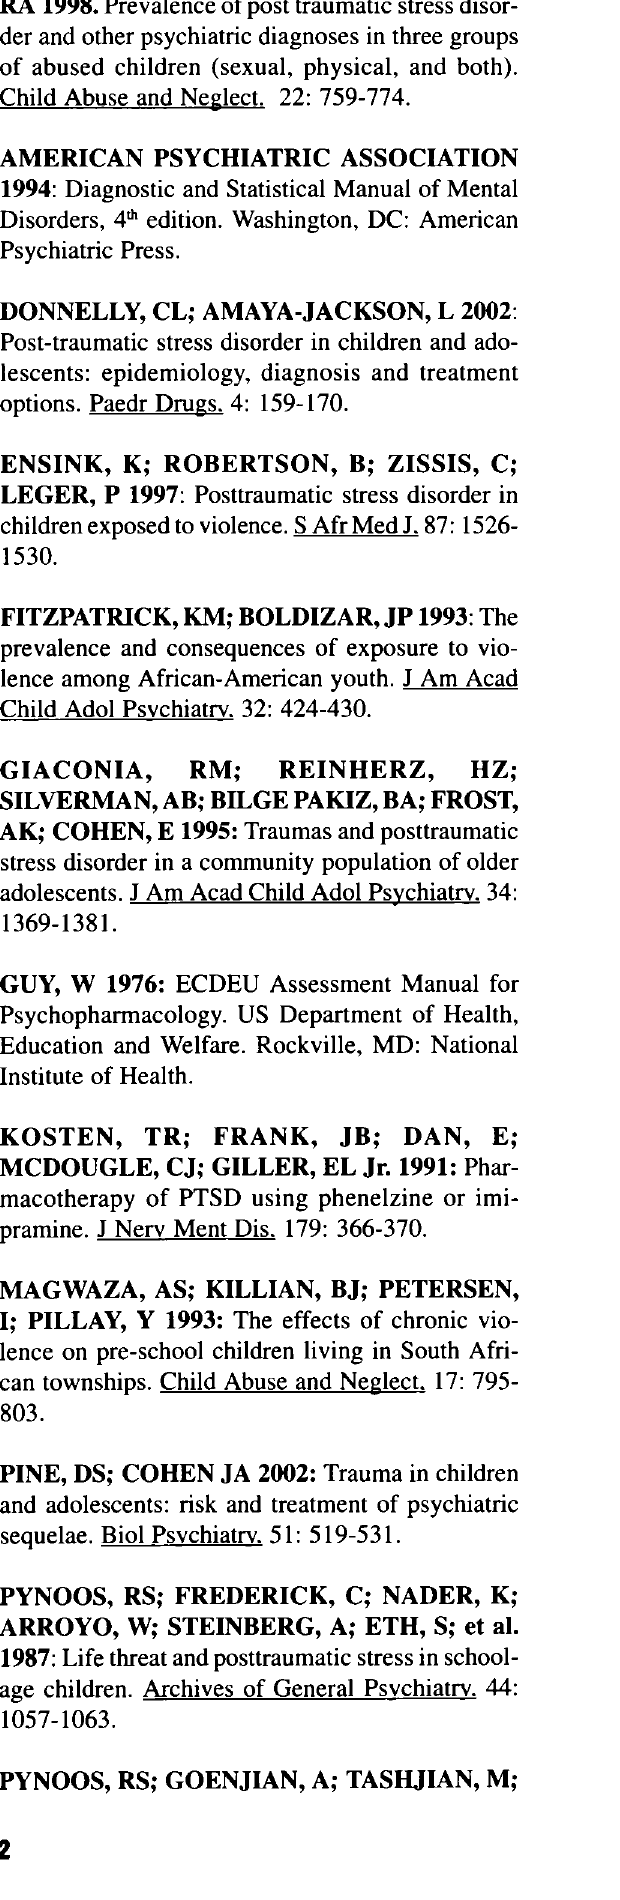
Table V I: Type of medication